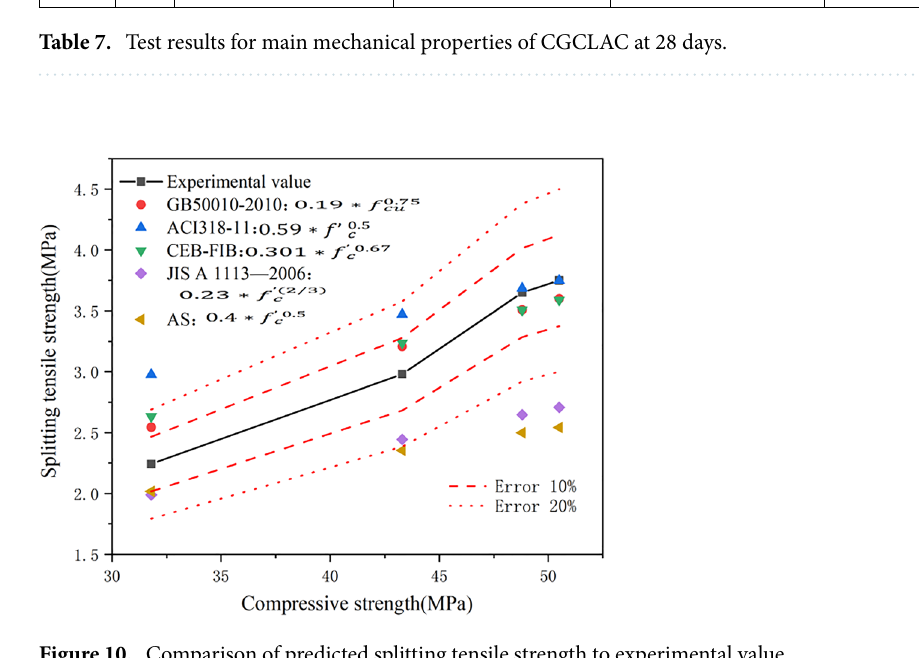
Figure 10. Comparison of predicted splitting tensile strength to experimental